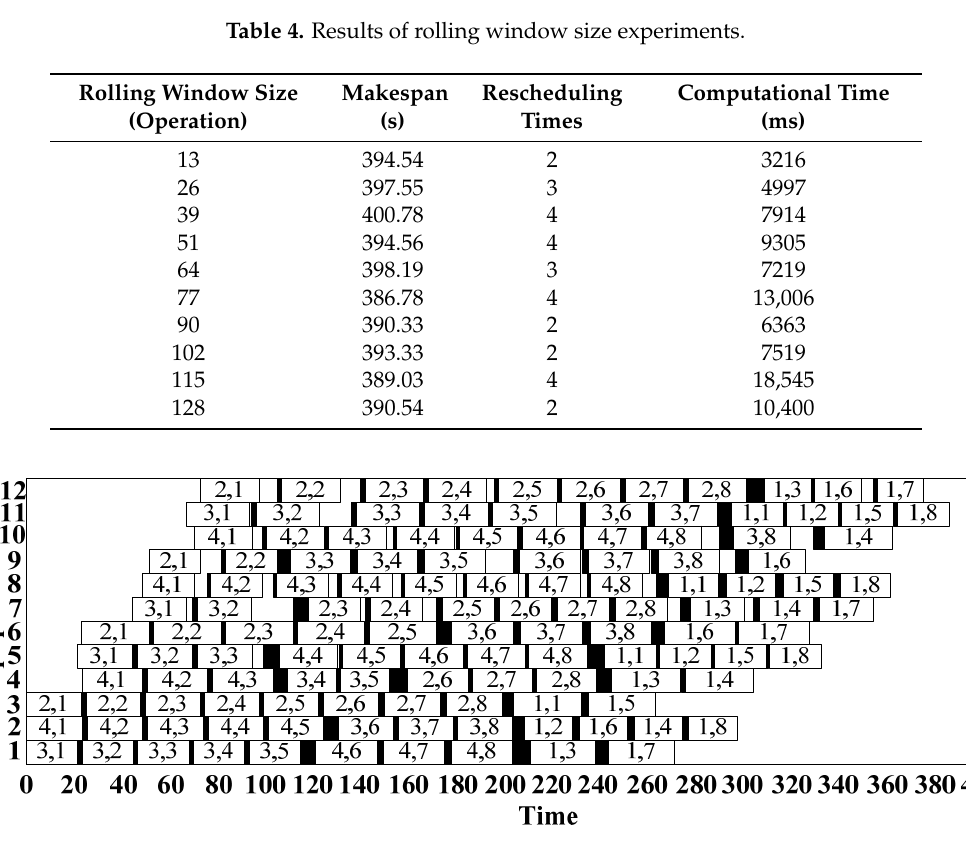
Figure 8. Gantt chart of a dynamic scheduling.